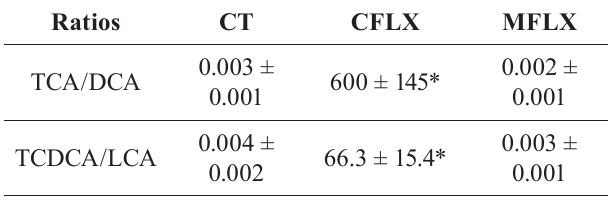
Data are means ± S.E.M (n = 5) * p < 0.05 compared to CT rats